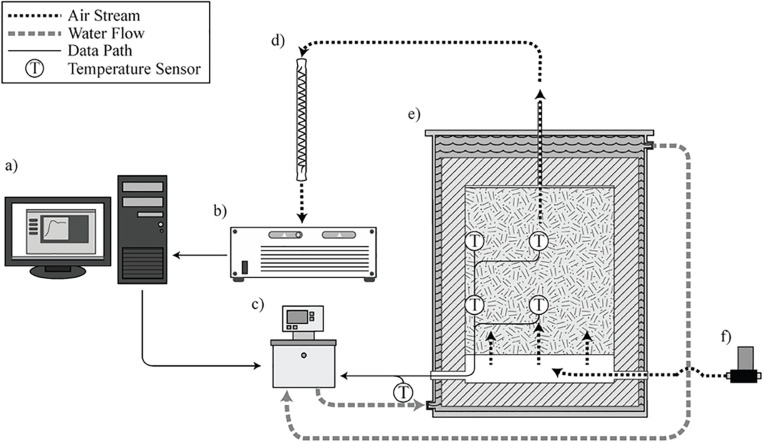
Operational illustration of the laboratory reactor system. (a) LabView control interface and data logging. (b) Gas chromatograph. (c) Heated water circulator. (d) Vapor condenser. (e) Reactor loaded with biomass in operation. (f) Mass flow controlled gas supply (Wendt et al., 2014; Bonner et al., 2015).